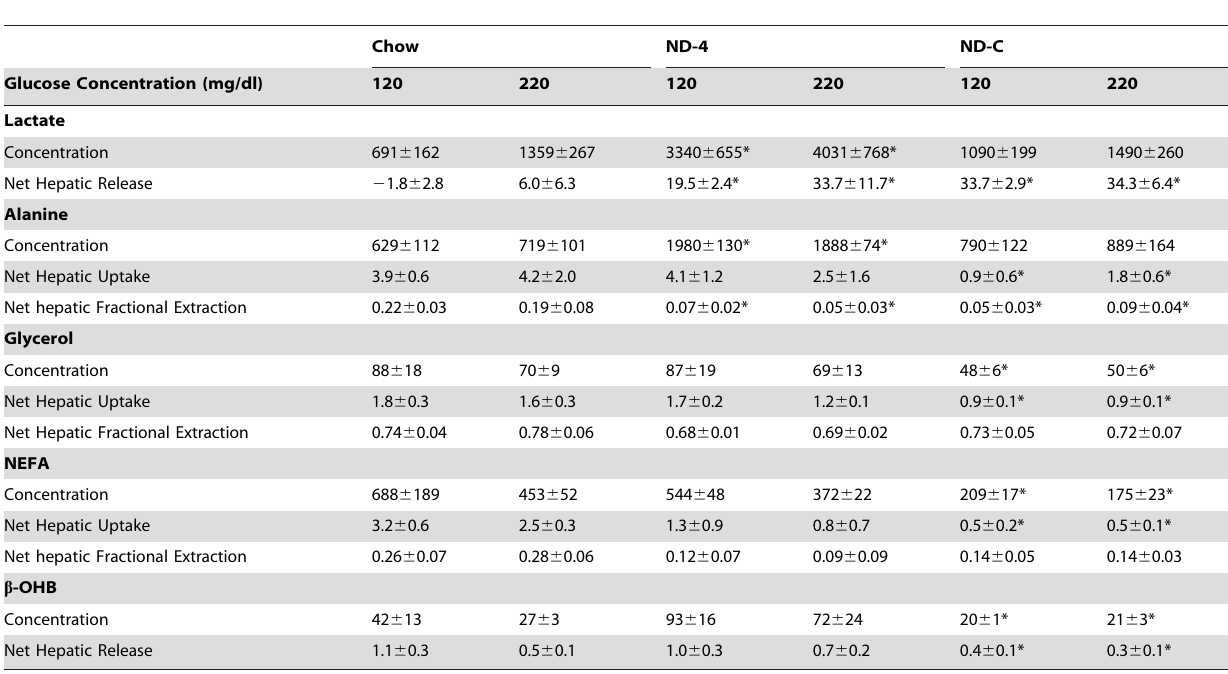
Table 2. Arterial Blood concentration ( m M), net hepatic uptake (or release; m mol ? kg 2 1 ? min 2 1 ) and fractional extraction of lactate, alanine, glycerol, non-esterified fatty acids (NEFA) and b -OHB in chronically catheterized conscious insulin-treated depancreatized dogs on a chow diet or fed an isocaloric nutritional support as a constant infusion (ND-C) or once a day for 4 days